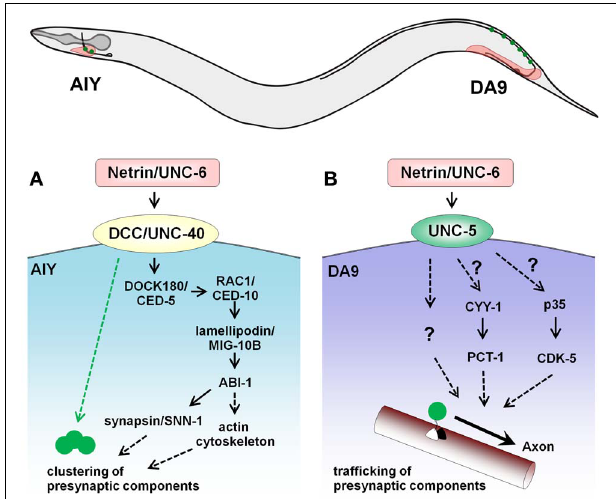
FIGURE 1 | Opposing roles of netrin/UNC -6 on synaptogenesis in the C. elegans AIY interneuron and DA9 motor neuron. (A) In the head region, glial sheath cells secrete UNC-6 and promote pre-synaptic assembly in AIY. UNC-6 signals through the DCC/UNC-40 receptor in AIY and recruits DOCK180/CED5 to pre-synaptic sites, leading to actin cytoskeleton remodeling and the pre-synaptic vesicle clustering. In addition, activation of UNC-40 clusters active zone proteins in a DOCK180/CED5-independent fashion (green dotted arrow). (B) In the tail, UNC-6 secreted by the ventral muscles acts through the UNC-5 receptor to prevent mislocalization of pre-synaptic components to the dendrite of the DA9 motor neuron. Pctaire kinase PCT-1, cyclin CYY-1, cyclin-dependent kinase CDK-5 and its activator p35 also regulate the kinesin/dynein-mediated localization of pre-synaptic components and may act downstream of UNC-6. The black arrow indicates the trafficking of components to the axon.